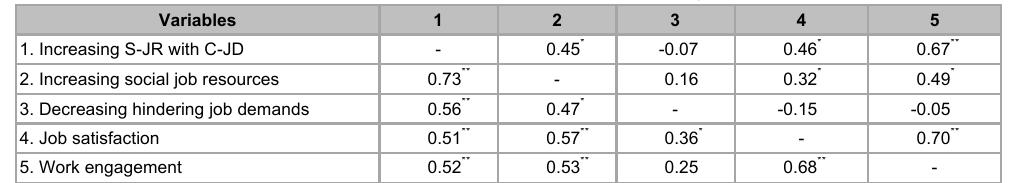
Correlation matrix for the latent variables in both groups Variables